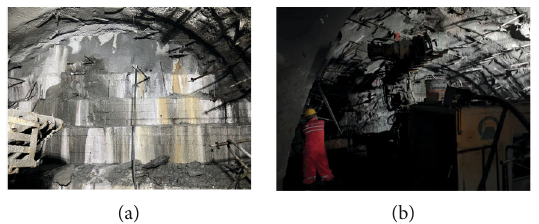
Figure 10: Project implementation. (a) Wall for grouting. (b) Grouting reinforcement.